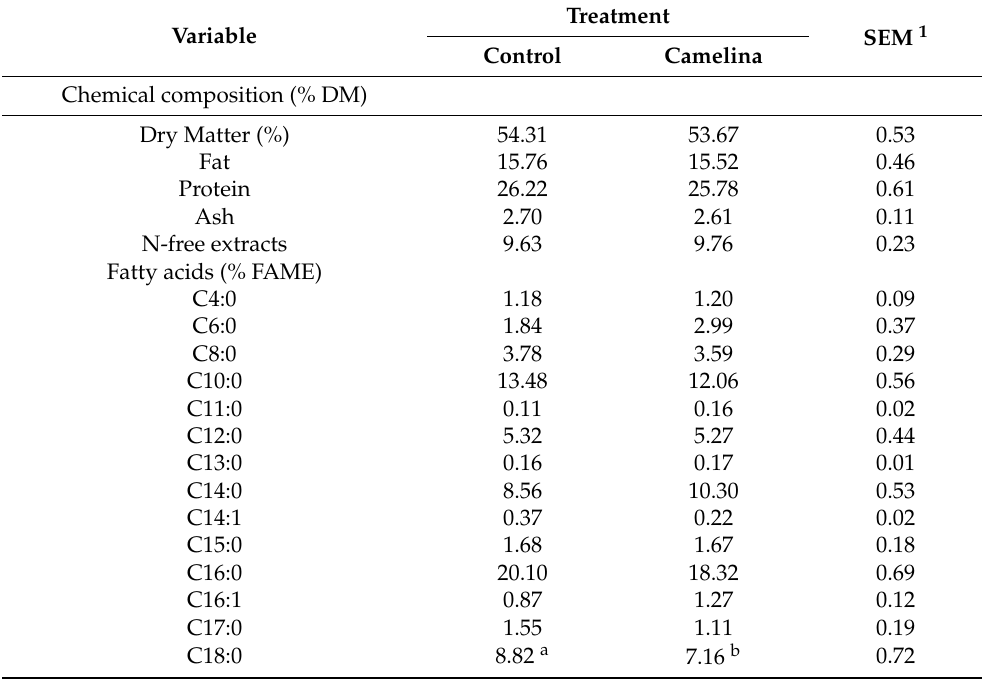
Table 3. Chemical and fatty acid composition of goat Caciotta cheese (mean ±